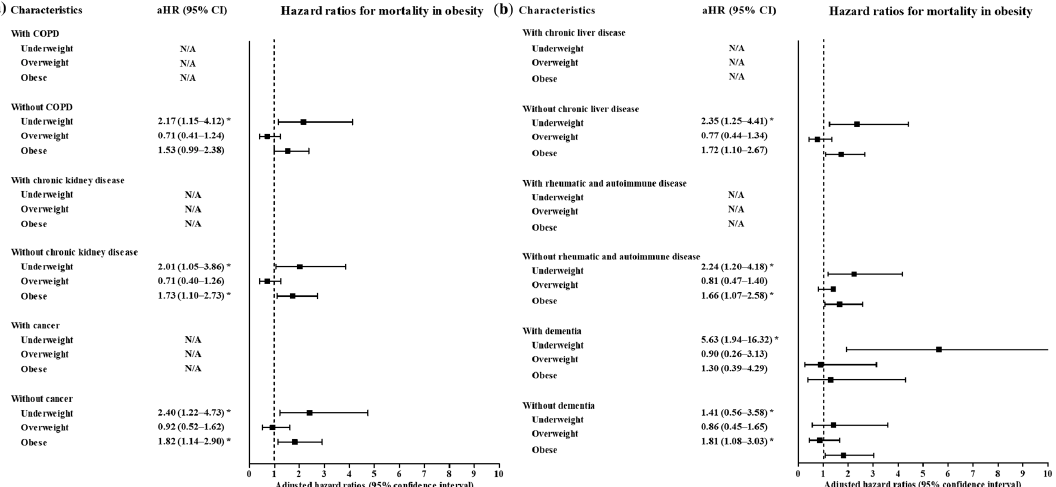
Figure 2. Subgroup analyses to obtain the adjusted hazard ratios (95% confidence interval) for mortality according to age, sex and hypertension ( a ) and heart failure, chronic heart failure and asthma ( b ). (* p < 0.05).